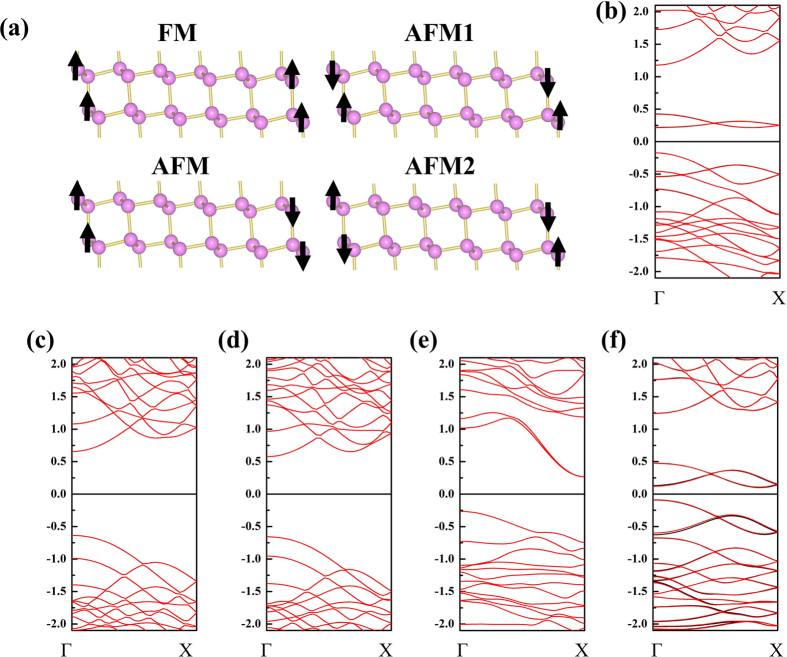
Different spin configurations and calculated band structures of ground states, (a) schematic of spin configurations, band structure of (b) 6-TPNR, (c) 6-TPNRH (d) 6-TPNRF, (e) 6-TPNRrec and (f) 6-TPNRO.